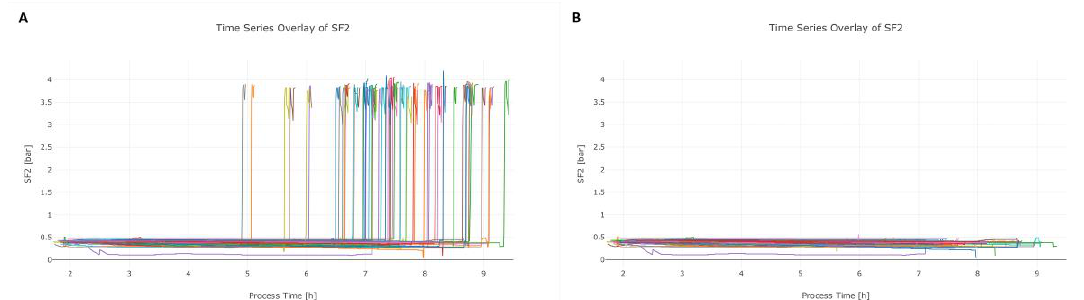
Figure 3. Data cleaning algorithm applied on signal SF2. The raw SF2 signals of various lots (different colors) are depicted in ( A ), whereas the high peak at the end of the process time is not relevant for monitoring and needs to be removed to enhance the performance for multivariate data analysis (MVDA). In ( B ), the corrected SF2 signal is depicted after the cleaning algorithm was applied. SF3 is used to track the progress of the filtration and therefore should slowly decrease over time.